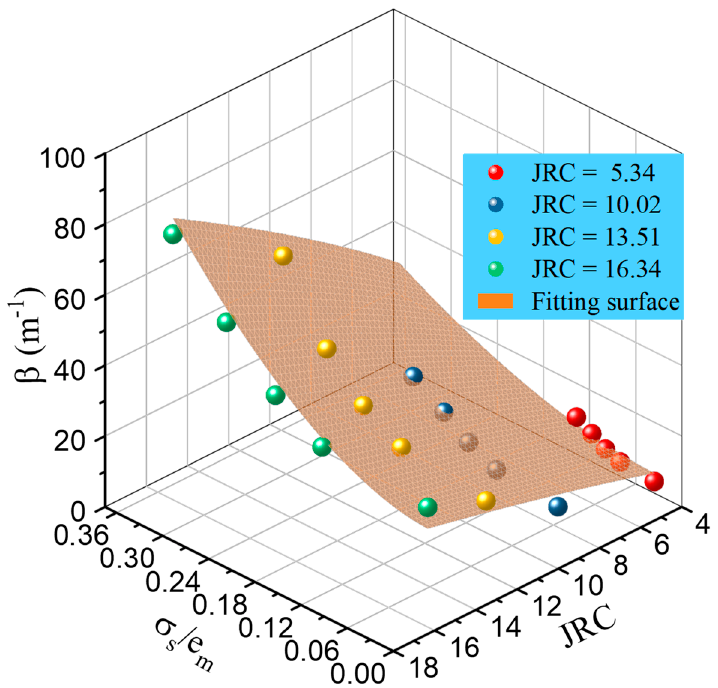
Figure 13. Non-Darcian coefficient results and fitting surface as a function of 𝜎 (cid:3046) /𝑒 (cid:3040) and JRCs.